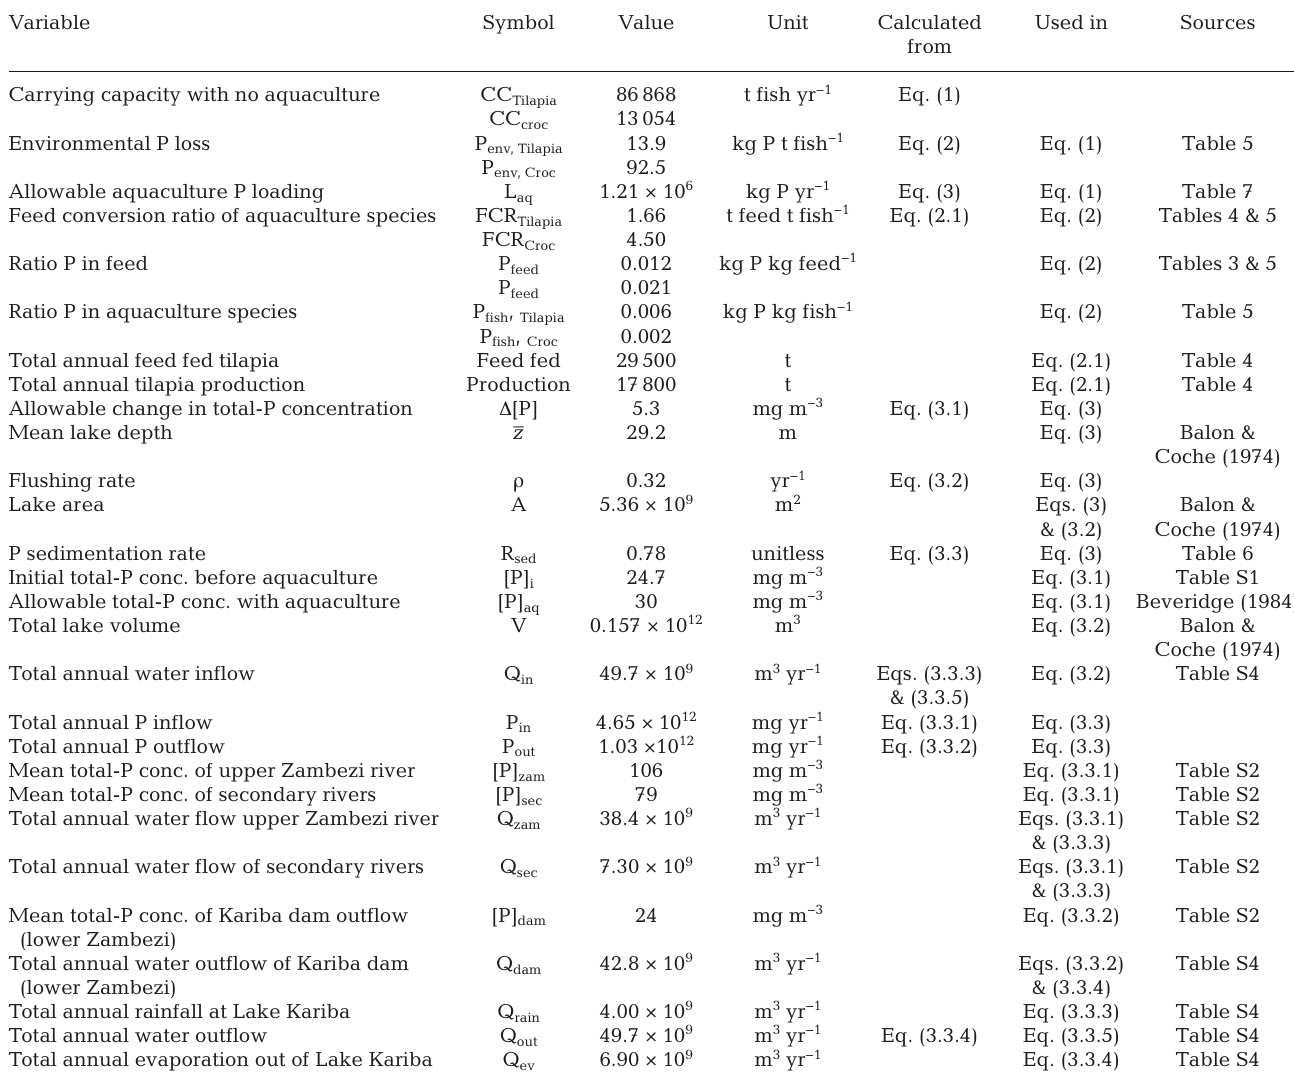
Table 2. List of all variables used in the main carrying capacity estimate, their values, the equations they are used in and their sources. Variables with empty cells were calculated using other